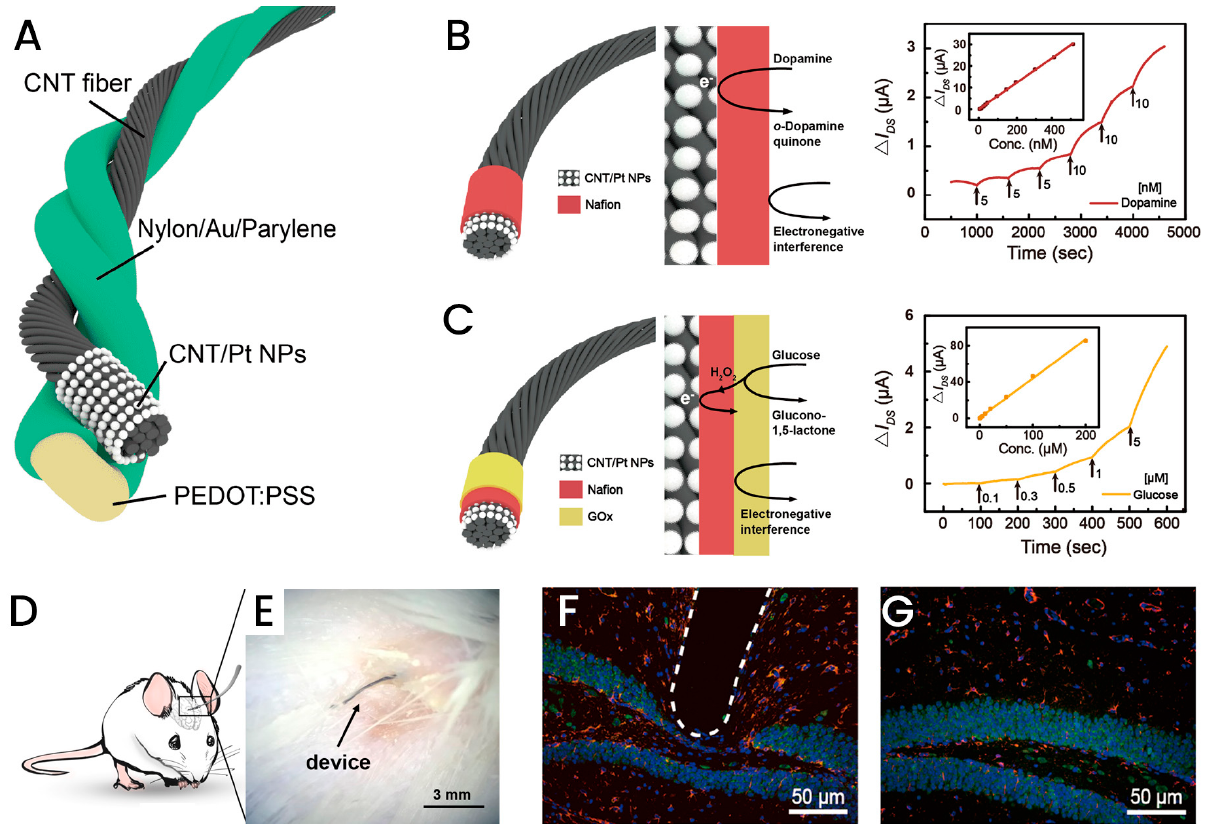
Figure 6. Fiber OECTs for biochemical detection of dopamine and glucose. ( A ) Representation of the OECT composition. ( B , C ) Example response towards dopamine and glucose. ( D , E ) Photograph of the OECT implanted on a mouse brain. ( F , G ) Demonstration of the OECT insertion in the brain followed through fluorescence staining. Reproduced with permission from ref. [67]. ©2020 Science China Press and Springer − Verlag GmbH Germany.